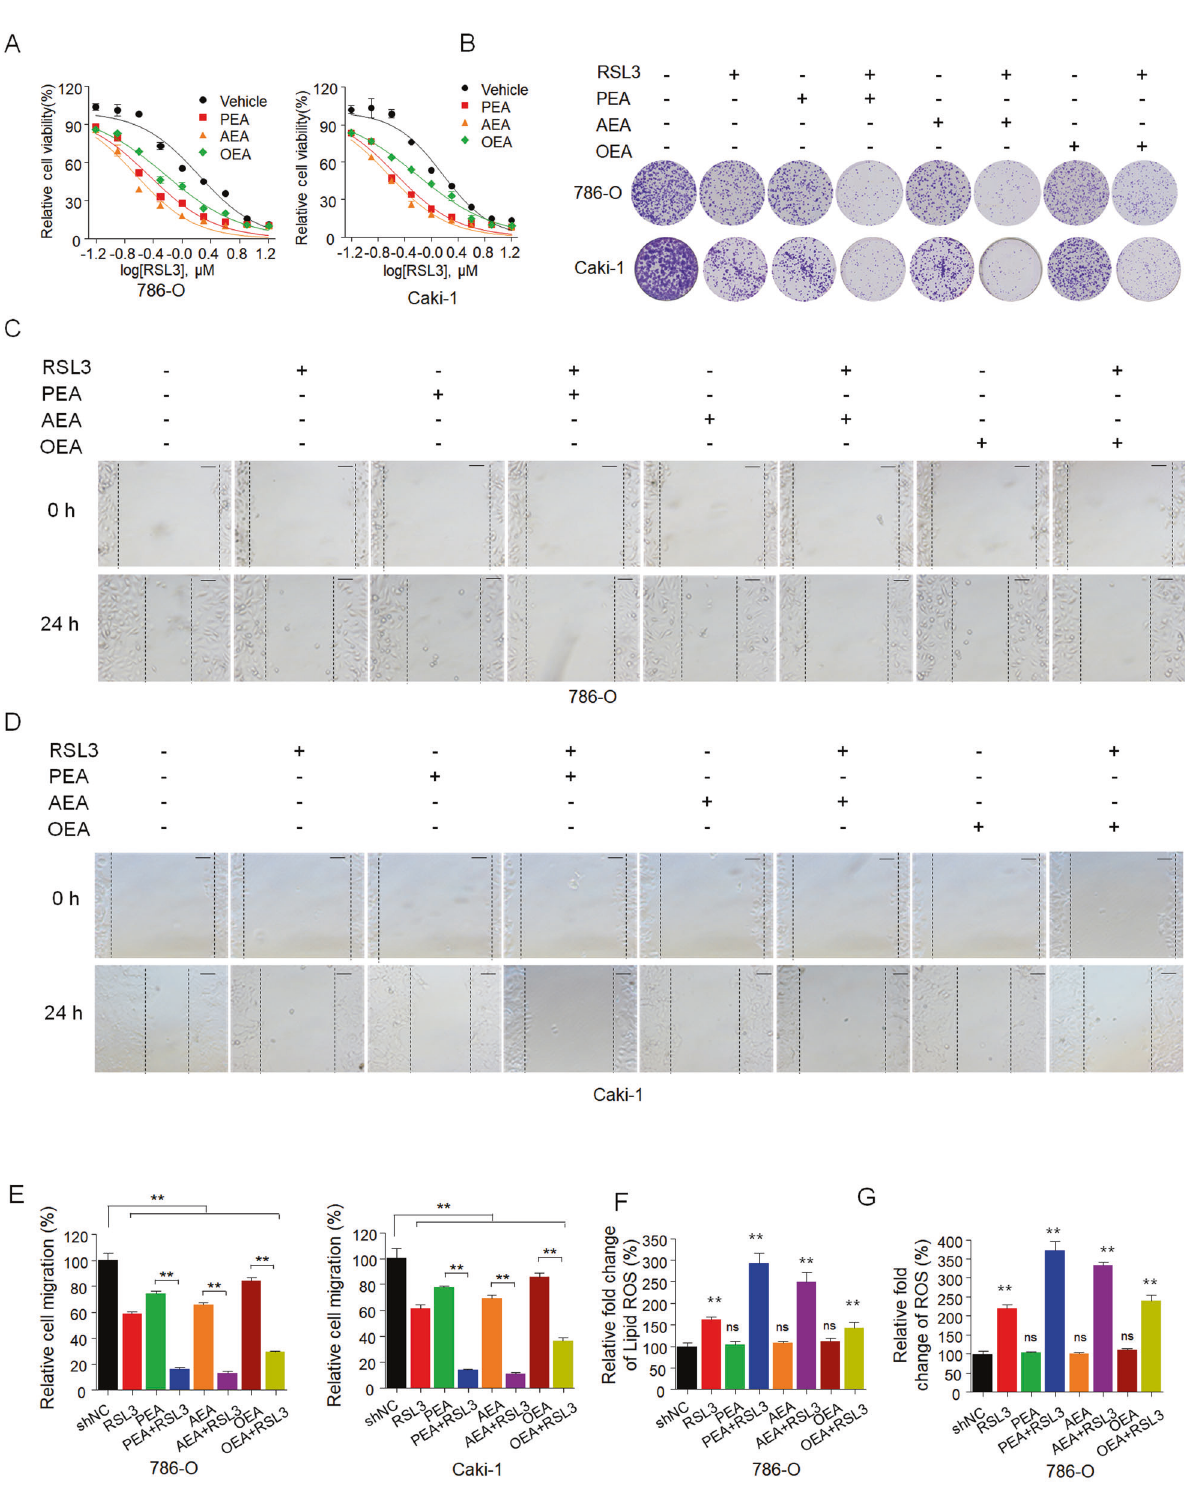
Fig. 4 FAAH substrates increase the sensitivity of RCC to ferroptosis inducers. A Dose – response curves for RSL3 as a single agent or combined with AEA, PEA, and OEA at the indicated doses in 786-O and Caki-1 cells for 72 h. Viability was measured 72 h after treatment. Effects on cell viability were calculated as the percentage of vehicle-treated cells. B In the colony formation assay, 786-O and Caki-1 cells were treated as in ( A ) for 14 days, and cells were fi xed and stained with crystal violet. C – E In the wound-healing assay, 786-O ( C ) and Caki-1 ( D ) cells were treated as in ( A ) for the indicated time. Histograms show the relative cell migration ( E ). Scale bar: 100 µm. Level of lipid peroxidation ( F ) and cytosolic ROS production ( G ) in 786-O cells treated as in ( A ) for 48 h. Lipid peroxidation and cytosolic ROS were assessed by fl ow cytometry with C11-BODIPY and H 2 DCFDA, respectively. Histograms show the relative fold change in the production of lipid ROS and cytosolic ROS (right panel). Data are means ± SDs of measurements repeated three times with similar results. ns (not signi fi cant), ** p < 0.01 (one-way ANOVA). Cell Death and Disease (2023)